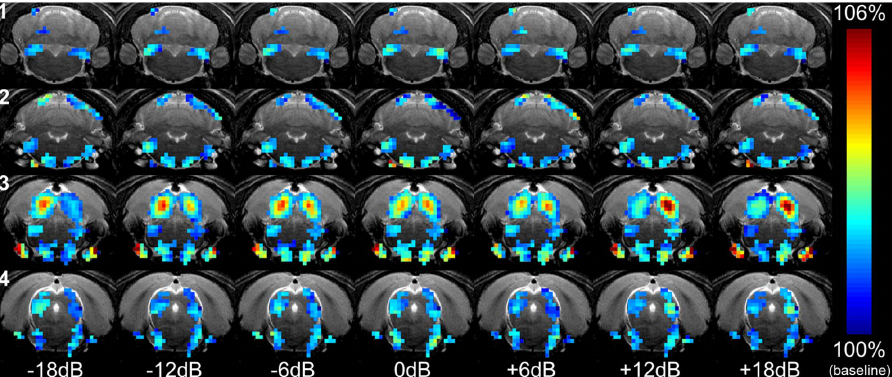
Figure 3. BOLD signal maps at different ILDs. BOLD signal maps at the seven ILDs acquired from the representative animal in Fig. 2. The BOLD signal is expressed as a percentage of the fMRI baseline signal and is color coded. The four slices and seven ILDs are arranged by row and column, respectively. Only activated voxels in Fig. 2 are color coded. ILD =0dB corresponds to the case where SPL is equal at the two ears. At negative ILDs, where SPL is greater in the right ear, higher signal is concentrated in the left SOC/LL, DLL, and IC. As ILD shifts positive (SPL greater in left ear), higher signal shifts to the right hemisphere. Activated voxels in the CN, SOC, and VLL do not exhibit significant ILD dependence. Structures are labeled in Fig. 2.